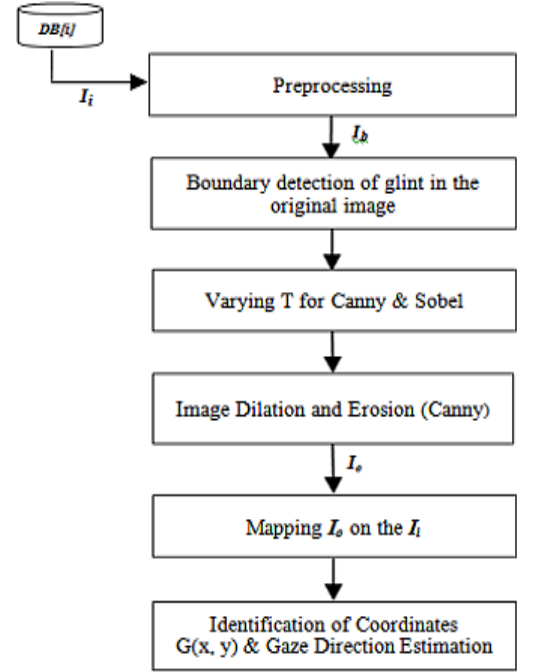
Figure 1: Workflow of proposed GDE algorithm.